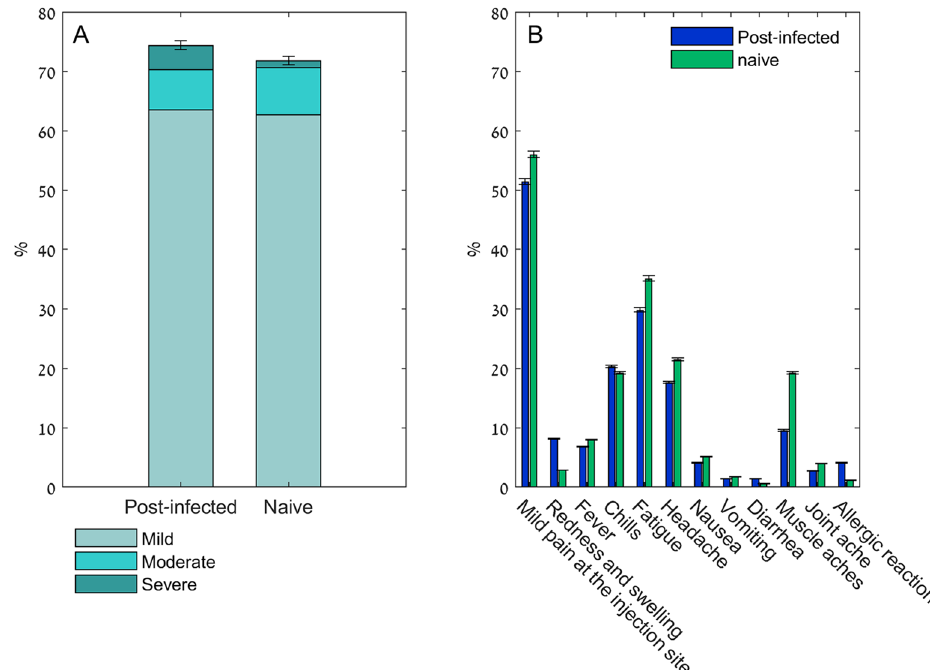
Figure 1. Local and systemic side effects reported after the first vaccine dose in the post-infected population (n = 78), and after the second vaccine dose in the naïve population (n = 177). ( A ) Overall side effects and symptoms in both populations (p = 0.88). ( B ) Relative frequency of each reported local and systemic side effects (a participant possibly having more than one symptom). Error bars represent 95% confidence intervals. Mild, does not interferes with daily activity; moderate, some interference with activity, or temperature > 38.5 °C; severe, prevents daily activity, temperature > 39 °C, or emergency department visit or hospitalization 3 .